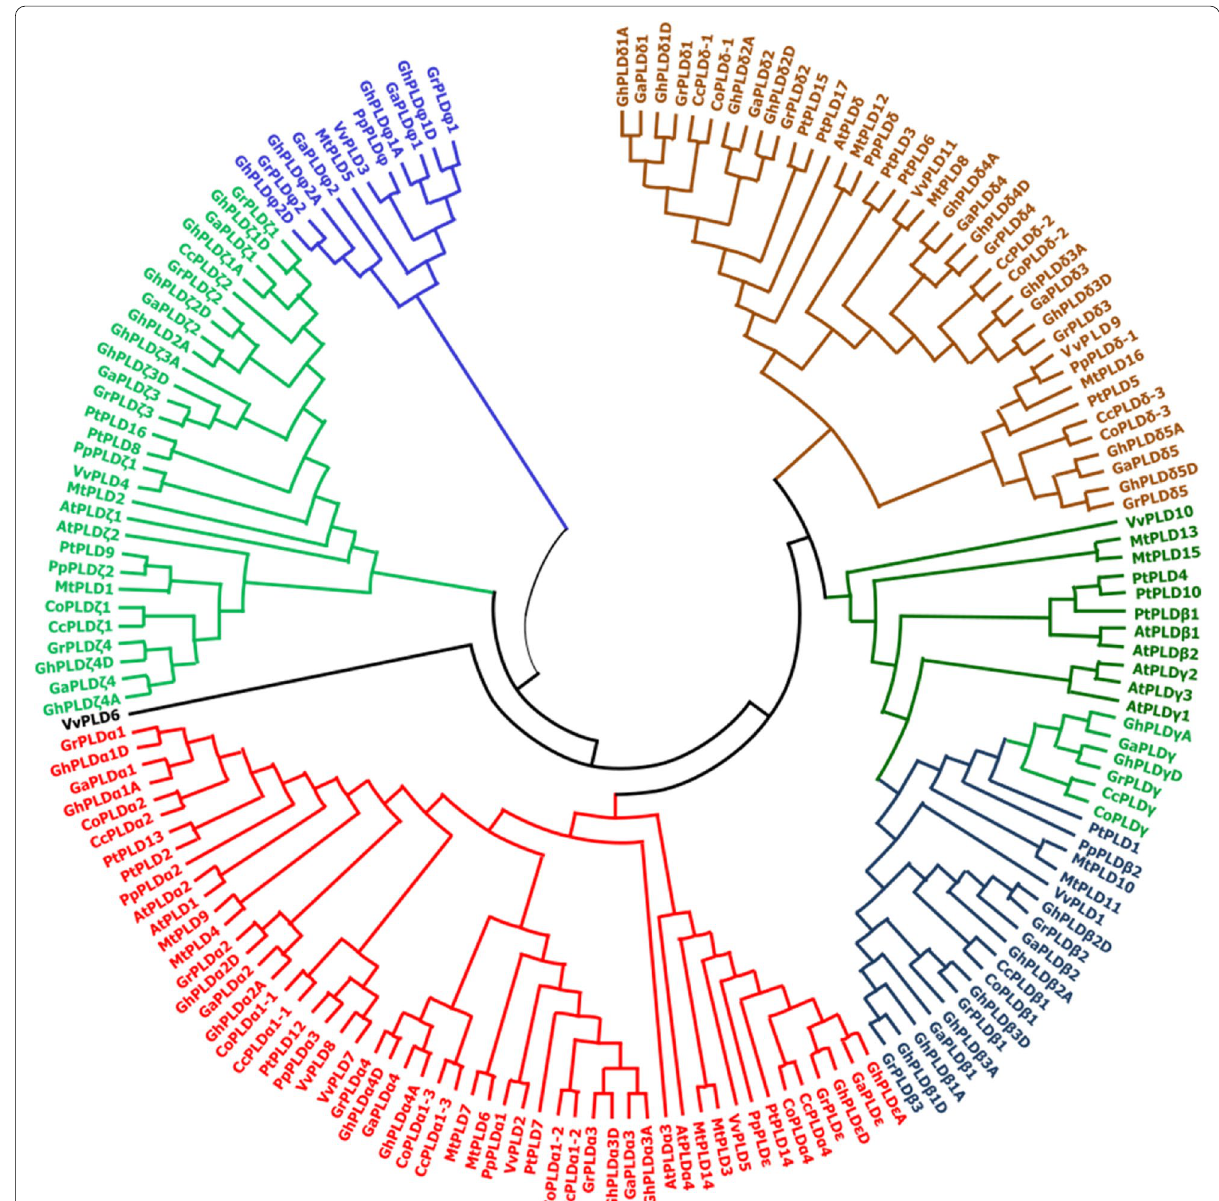
Fig. 4 Phylogenetic relationship of PLD proteins among the C . olitorius , C . capsularis with different plant species. The phylogeny tree was constructed with MEGA X and neighbor-joining (NJ) method and 1000 replicates bootstraps where Cc, Co, At, Gh, Gr, Ga, Vv, Mt, Pt, and Pp indicates Corchorus capsularis , C . olitorius , Arabidopsis thaliana , Gossypium hirsutum , G . raimondi , G . arboretum , Vitis vinifera , Medicago truncaluta , Poplus tremula , and Prunus persica ,